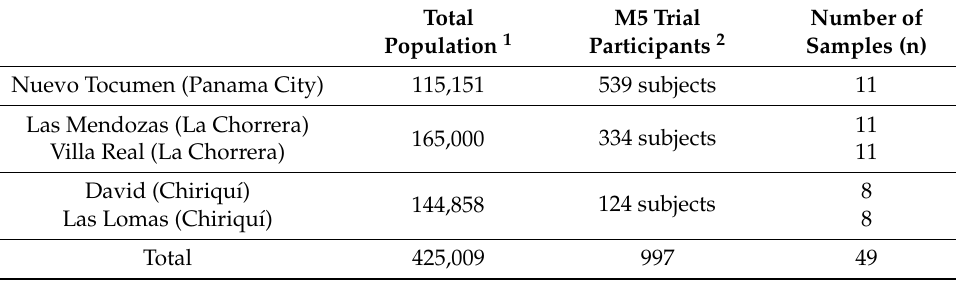
Table 1. Collection site characteristics and number of samples.